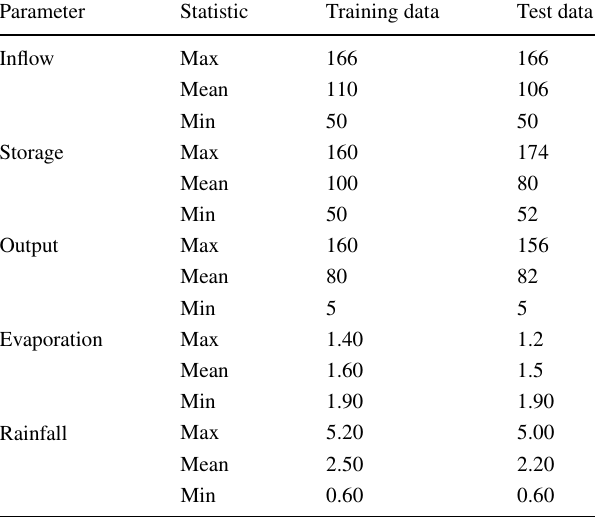
Table 3 Statistical parameters of training and testing datasets Parameter Statistic Training data